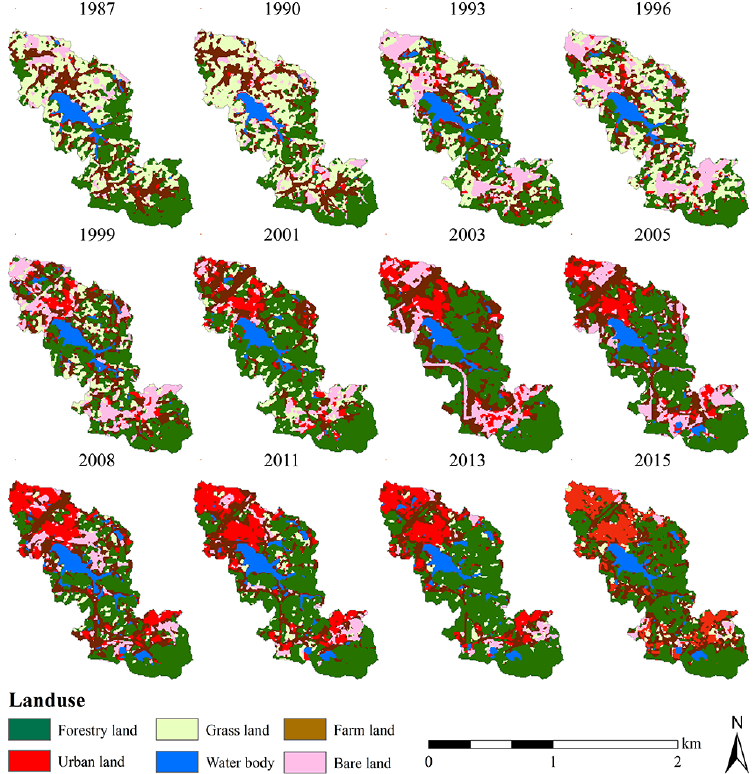
Figure 3. Land use/cover from 1987 to 2015 of Shigu creek.